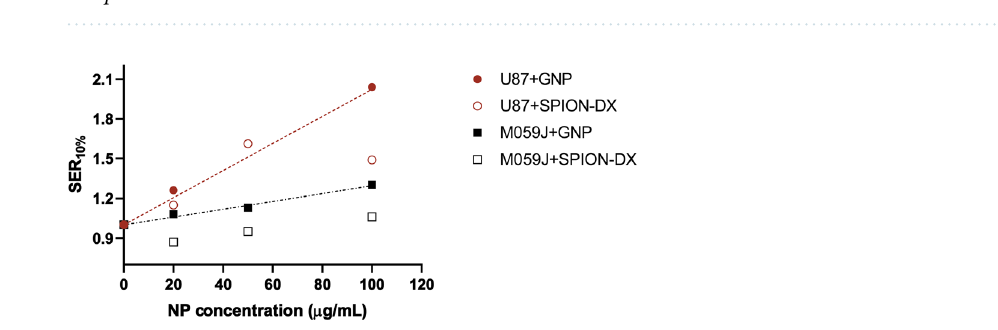
Figure 3. Cell survival curves for M059J GBM cells treated with GNPs ( a,b ), and SPION-DX ( c,d ) at concentrations of 20, 50 and 100 µ g/mL. Data for untreated cells (control) are also shown. Samples were irradiated by photons from a 6 MV Linac accelerator in triplicate. The same data was plotted as bar graphs for a better visualization of single dose effect. p -values are presented as: * p < 0.05 ; ** p < 0.01 ; *** p < 0.001 ; **** p < 0.0001 .